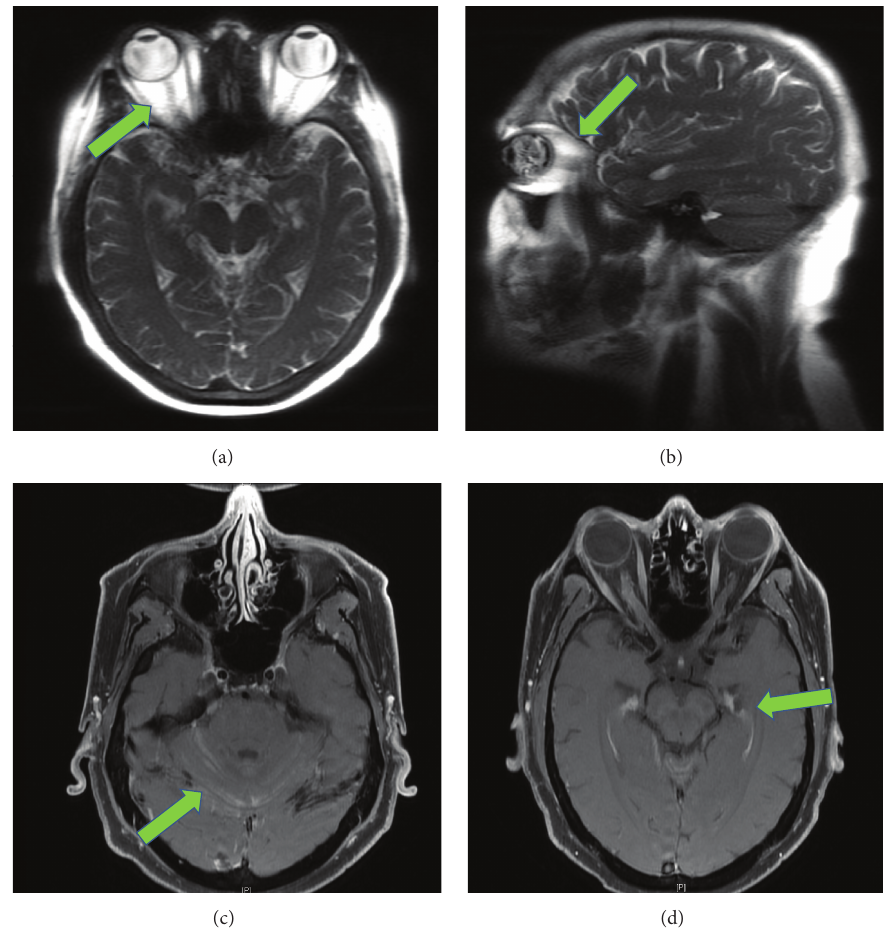
Figure 1: MRI of the brain and orbits. Images show asymmetric enhancement of the right optic nerve sheath (panels (a) and (b)). Arrow denotes greater enhancement in the right optic nerve sheath compared to the left optic nerve sheath, consistent with his clinical presentation. Patient also had bilateral cerebellar surface enhancement (panel (c)) and bilateral trigeminal nerve enhancement (panel